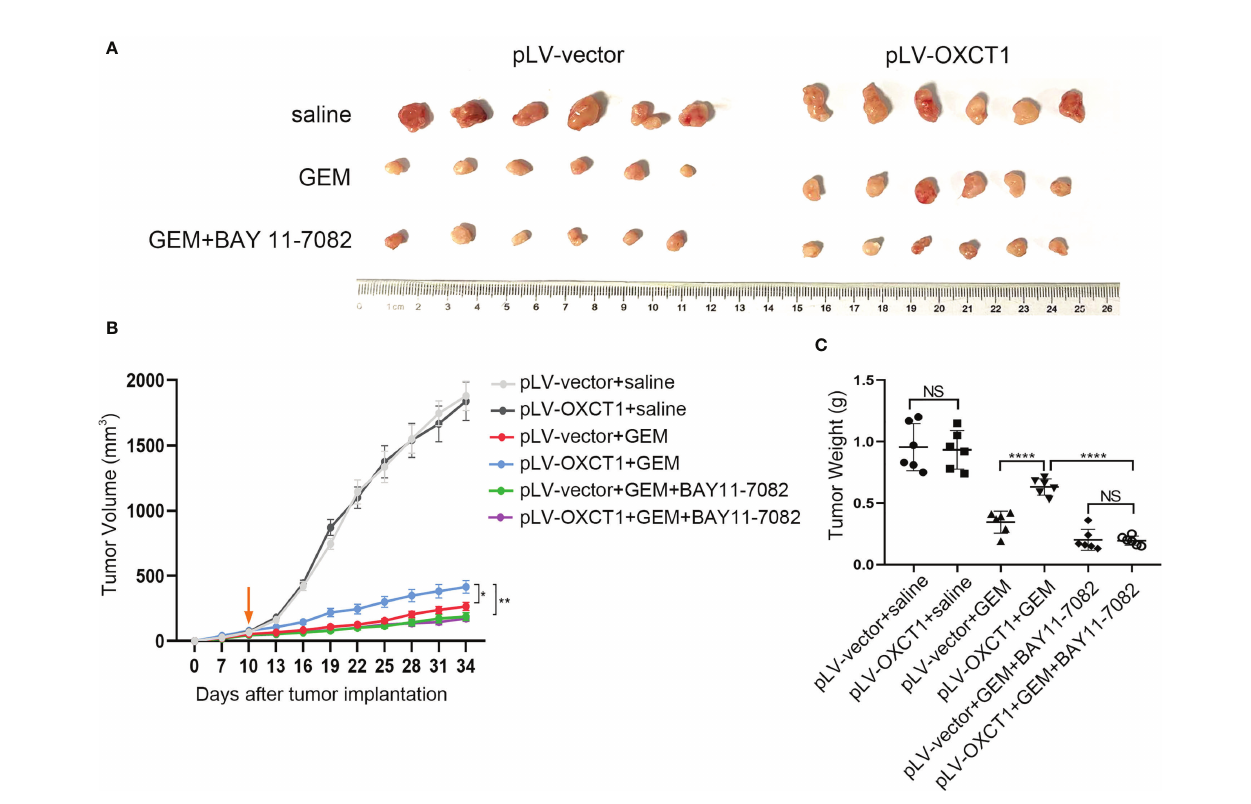
FIGURE 5 | NF- k B inhibitor reversed OXCT1-induced PDAC resistance to GEM in mouse models. (A – C) The indicated tumor cells were subcutaneously transplanted into the nude mouse model to develop tumors (n=6 for each group). Ten days later, the mice were treated with saline, GEM, or the combination of GEM and BAY 11-7082. Tumor volumes were measured every 3 days using the calipers. Then, the mice were sacri fi ced, and tumors were excised. The representative images of the tumors are depicted (A) . Repeated measure two-way ANOVA (time × tumor volume) analysis was performed to compare the tumor growth curve among the six groups (B) . Tumor weights at the end of the experiment are also shown and were analyzed (C) . Data are presented as mean ± SD; * P < 0.05; ** P < 0.01; **** P < 0.0001. NS, not signi fi